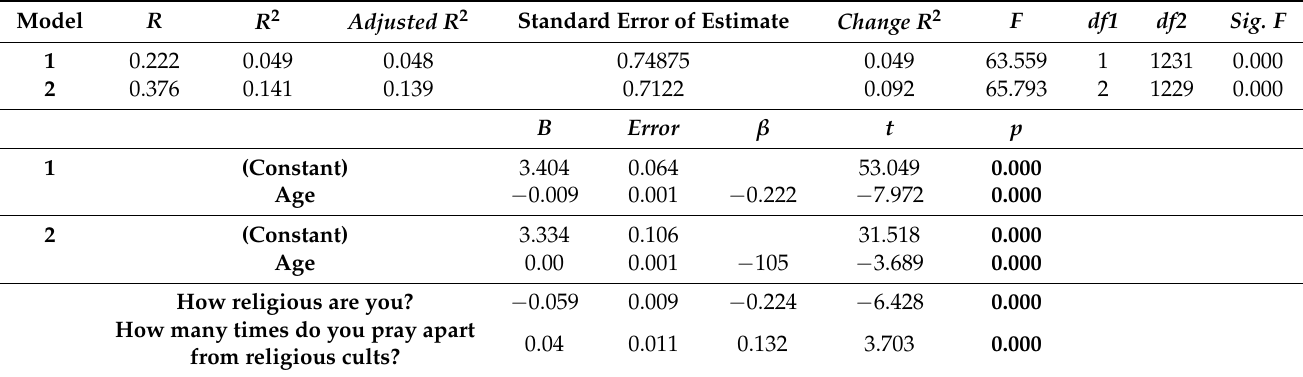
Table 6. Multiple linear regression 2: Contribution to the explanation of the second-order dimension